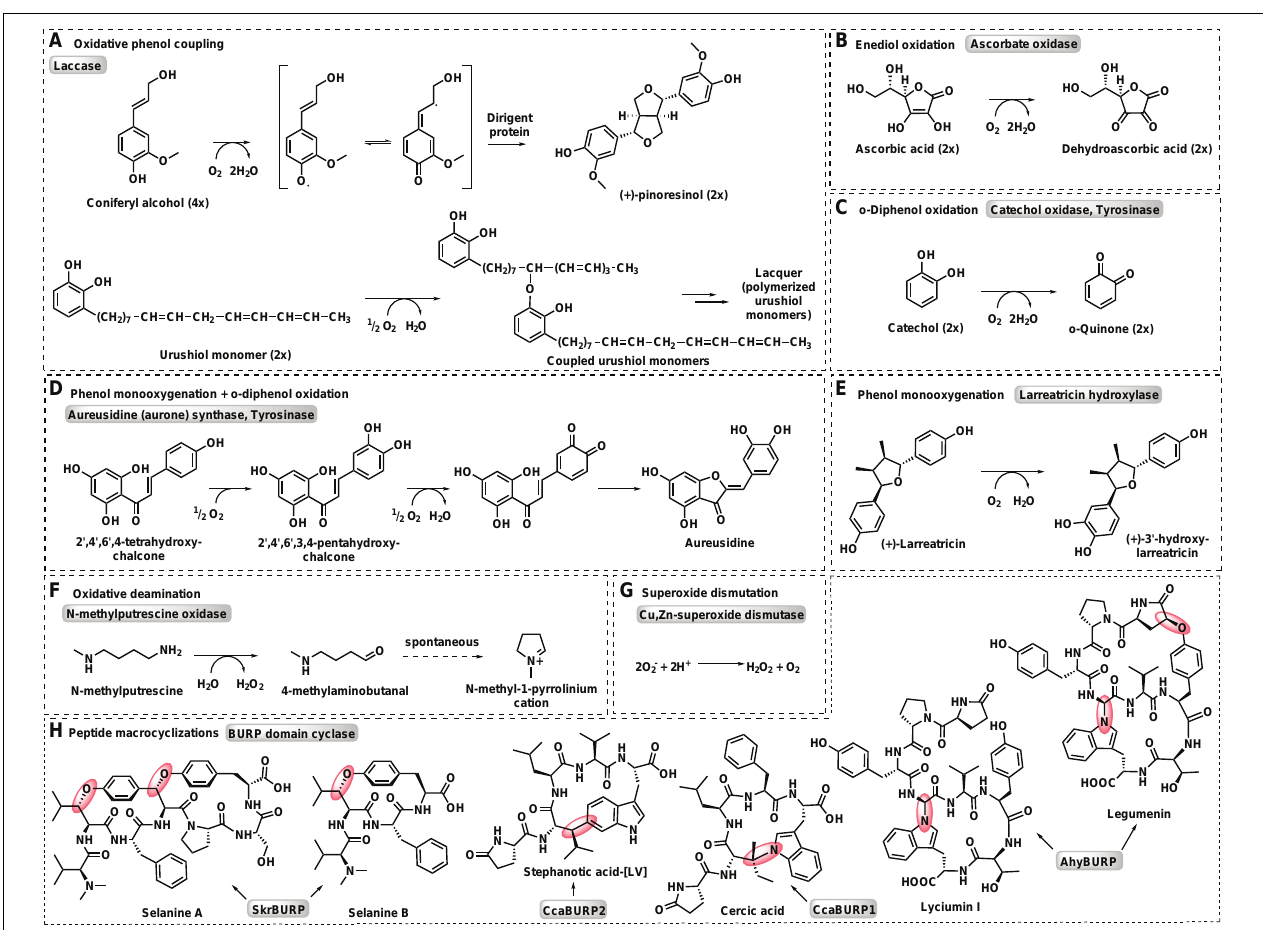
FIGURE 1 | Representative metabolic reactions catalyzed by plant copper metalloenzymes. (A) Oxidative phenol coupling by laccase. (B) Enediol oxidation by ascorbate oxidase. (C) o -Diphenol oxidation by catechol oxidase and tyrosinase. (D) Phenol monooxygenation and o -diphenol oxidation by aurone synthase and tyrosinase. (E) Phenol monooxygenation by larreatricin hydroxylase. (F) Oxidative deamination by N -methylputrescine oxidase. (G) Superoxide dismutation by Cu, Zn-superoxide dismutase. (H) Peptide macrocyclizations by BURP domain cyclase.